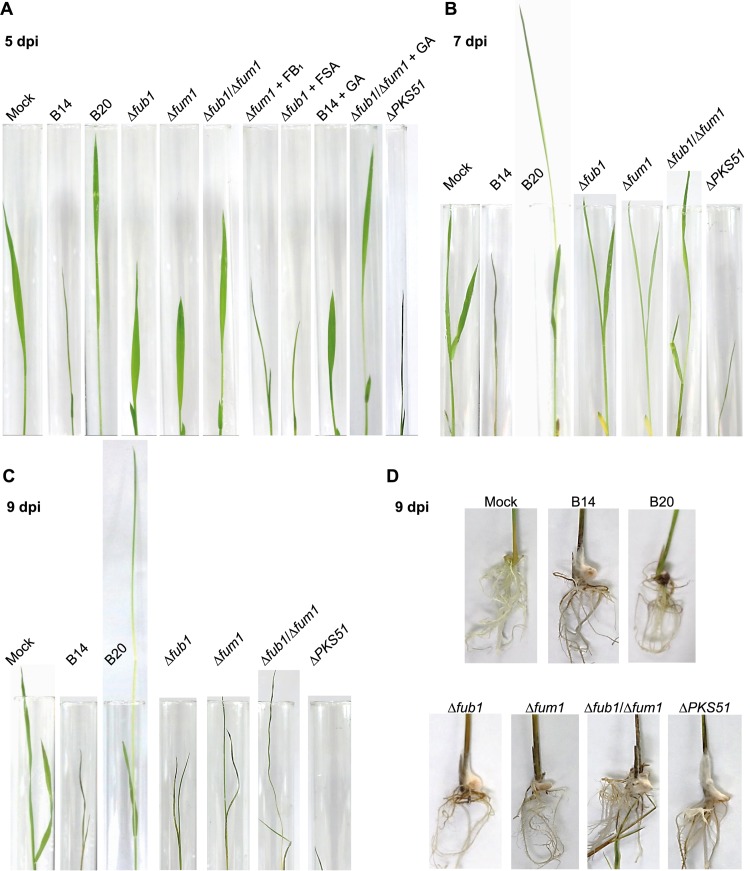
Shoot and root growth of rice seedlings 5, 7, and 9 days post inoculation (dpi) of F. fujikuroi B14 and gene deletion strains dervied from B14.(A-C) Shoot growth. (D) Root growth. (A) Shoot and root growth 5 dpi with or without exogenous supply of fumonisin FB1 (1 μM), fusaric acid (FSA; 10 μM) or GA3 (10 μM). (B) Shoot growth 7 dpi. (C) Shoot growth 9 dpi. Mock: neither fungal inoculation nor toxin treatement; B14 (stunting pathotype) and B20 (bakanae pathotype) wild-type strains; Δfub1 (PKS6, fusaric acid) deletion strain; Δfum1 (PKS11, fumonisins) deletion strain; Δfub1/Δfum1 double deletion strain; ΔPKS51 (PKS51, unknown product).